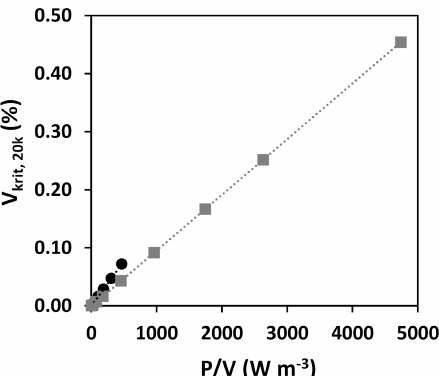
Figure A5. Critical reactor volume fractions with energy dissipation rates above 20 kW m − 3 plotted over the corresponding averaged power input. Black circles represent values for the SIS, grey squares those of the